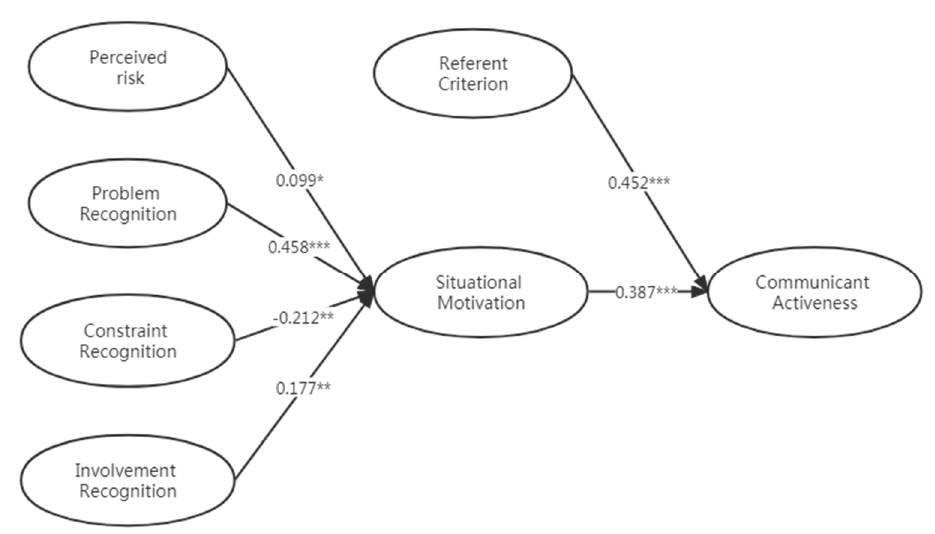
Figure 2. Normalized path coefficient diagram. * p < 0.05; ** p < 0.01; *** p < 0.001.